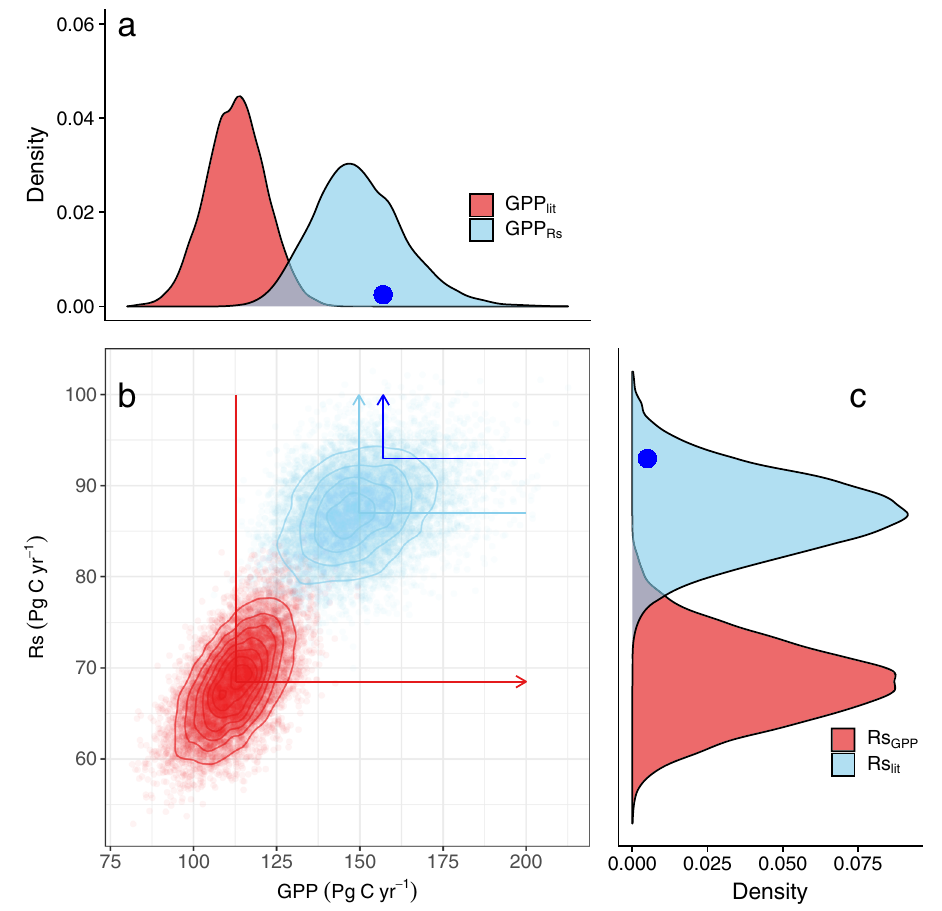
Fig. 1 Distribution and comparison of annual global soil respiration (R S ) and gross primary productivity (GPP). a Distributions of global gross primary productivity (GPP lit and GPP Rs ); b Joint distribution of annual global soil respiration (R S ) and gross primary productivity (GPP); c Distribution of global soil respiration (Rs lit and Rs GPP ) estimates. Two distributions are shown: literature-reported GPP (GPP lit ) versus GPP implied by those R S estimates (GPP Rs ); or literature-reported R S (Rs lit ) versus R S implied by those GPP estimates (Rs GPP ); Distributions are based on 10,000 random draws of the underlying estimates from published literature (summarized in supplementary Fig. 8). The red arrow represents from GPP lit to calculate Rs GPP , the light-blue arrow represents from Rs lit to calculate GPP Rs , and the blue dots and line represent R S from the random forest model developed in this study and based on that to calculate the GPP Rs . The arrows and direction corresponding to the arrows in supplementary Fig.